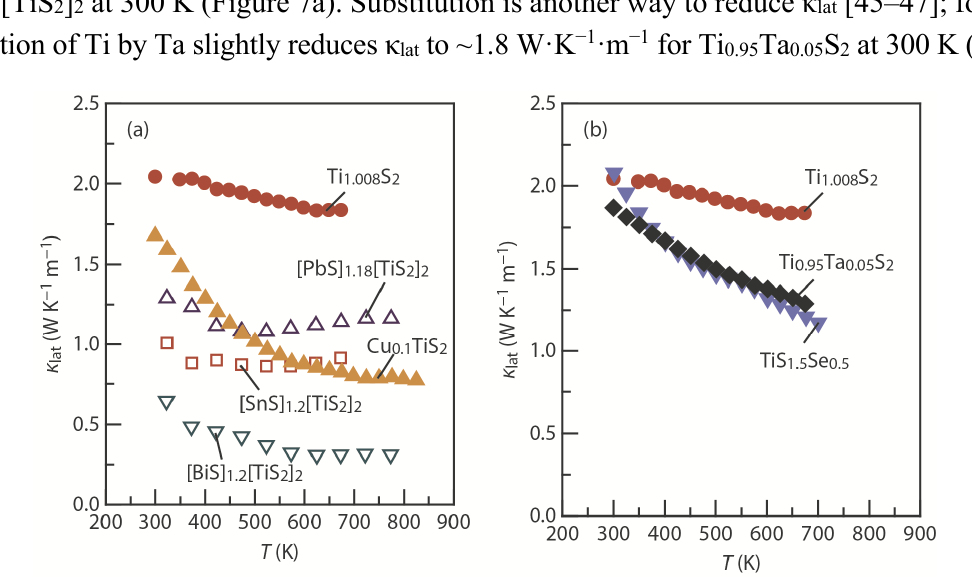
Figure 7. Temperature dependence of the lattice thermal conductivity ( κ lat ) in the in-plane ( ab -plane) direction for Ti 1.008 S 2 [29]: ( a ) intercalated systems [BiS] 1.2 [TiS 2 ] 2 [42], [PbS] 1.18 [TiS 2 ] 2 [42], [SnS] 1.2 [TiS 2 ] 2 [43], and Cu 0.1 TiS 2 [44]; ( b ) substituted systems TiS 1.5 Se 0.5 [45] and Ti 0.95 Ta 0.05 S 2